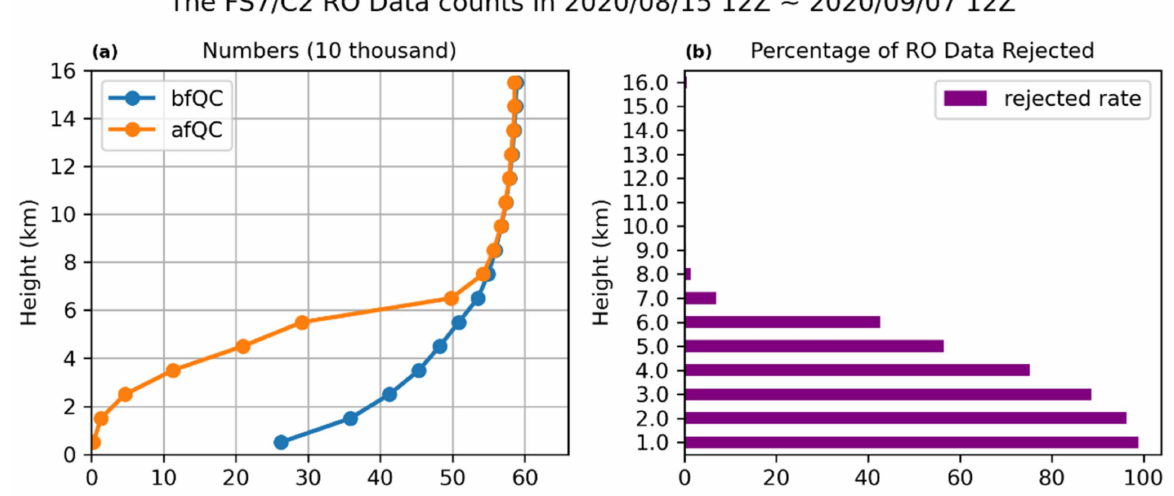
Figure 3. ( a ) Statistics of the F7/C2 RO counts in the experiment domain before QC (blue line) and after QC (orange line) during the experimental period. ( b ) Rejection